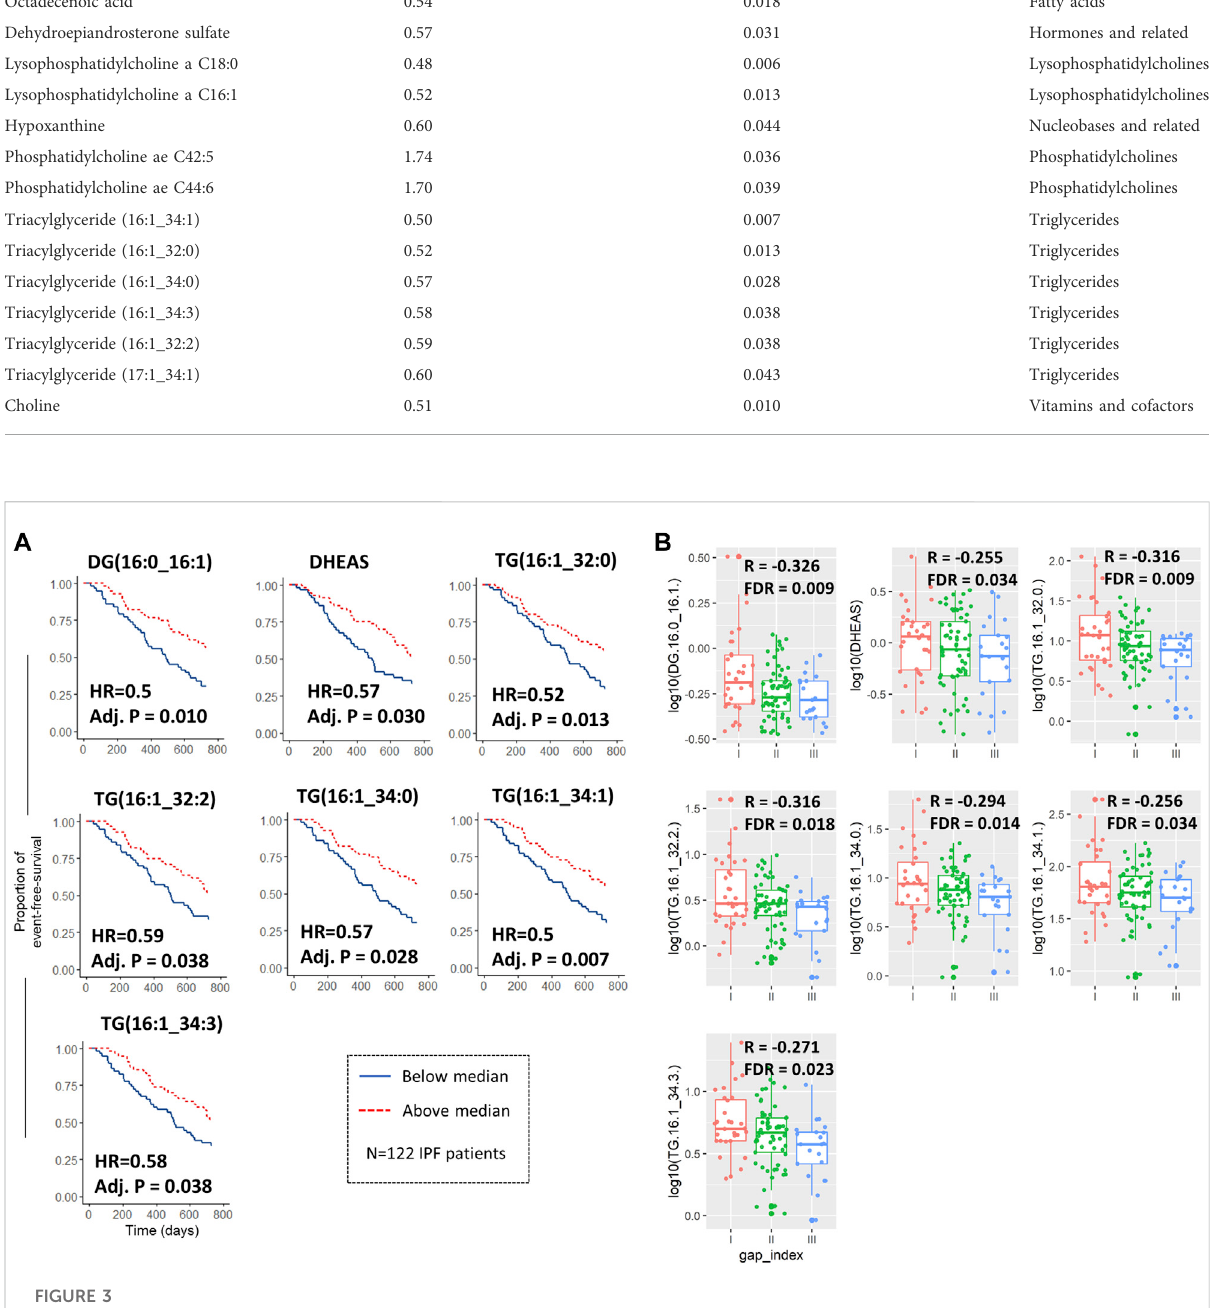
FIGURE 3 Metabolites and lipids both associated with survival/composite endpoint and baseline GAP score. Kaplan-Meier curves with adjusted hazard ratios and p -values for the 7 analytes which were signi fi cantly associated with both the 2-years composite endpoint when dichotomized by median and also with Gender, Age, and Physiology (GAP) score at baseline (A) . Log10 transformed analyte abundance was plotted against the resulting GAP indices at baseline as box-jitter-plots with associated Person correlation coef fi cients (between abundance and GAP score) and false discovery rate (B) . All IPF patients of cohort 1 were included in the analysis (n =